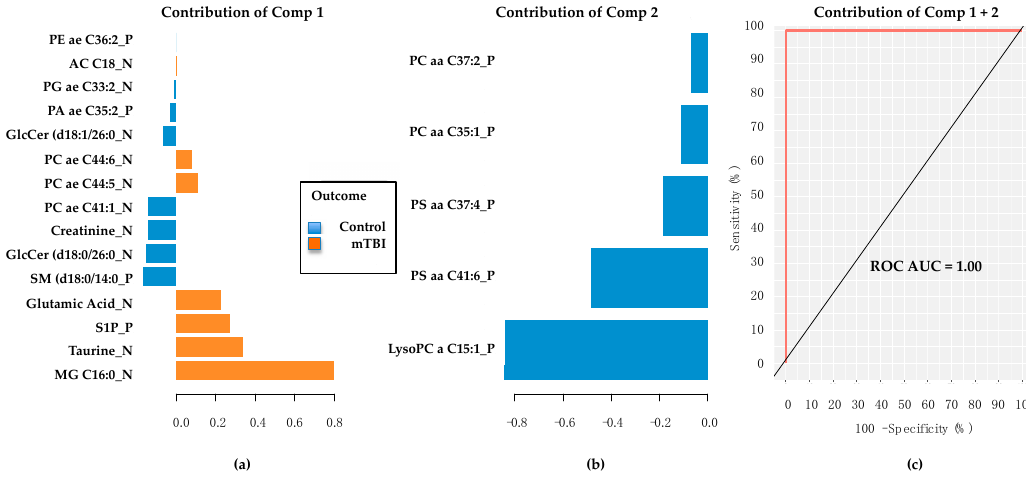
Figure 2. Metabolites associated with first two discriminant components. ( a ) The first component provides 15 metabolites, and the bottom 4 listed providing the greatest contributions (all higher in TBI cases) to classification accuracy. ( b ) The second principal component provides 5 metabolites (all lower in TBI controls). ( c ) Receiver operating characteristic area under the curve (ROC AUC) provides result of 1.00 using 20 metabolites from the two components in the classifier model. Comp = sPLS-DA model component. PE = phosphatidylethanolamine. AC = acylcarnitine. PG = Phosphatidylglycerol. PA = Phosphatidic acid. GlcCer = glucosylceramide. PC = phosphatidylcholine. SM = sphingomyelin. S1P = sphingosine-1-phosphate. MG = Monoacylglycerol. PS = phosphatidylserine. LysoPC = lysophosphatidylserine. Final metabolite identifications will require additional tandem mass spectrometry (MS/MS) analyses. Metabolites confirmed via MS/MS are considered fully validated, to a high degree of